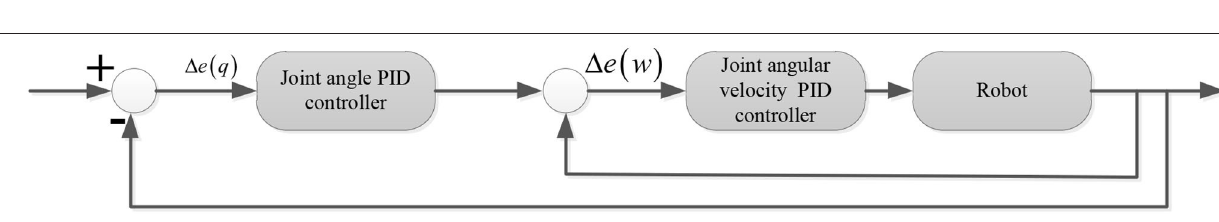
FIGURE 4 | Trajectory generator based on obstacle avoidance for the robot.